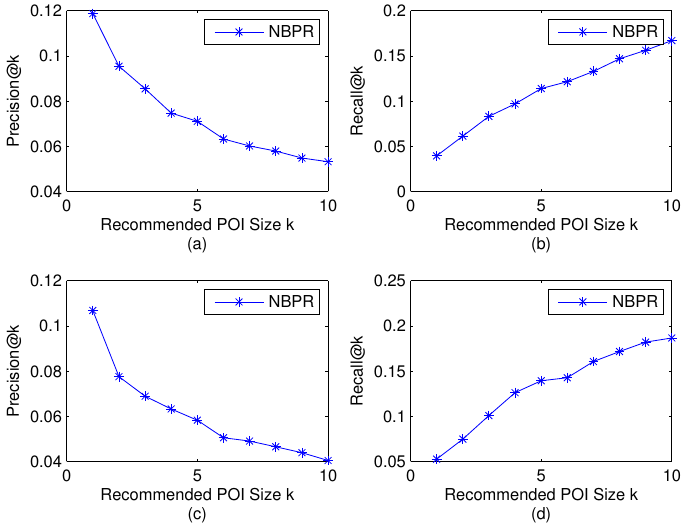
Figure 5. The recommendation performance of our method with the changes of the recommendation number in two LBSNs. ( a ) Precision@ k in the Gowalla data; ( b ) Recall@ k in the Gowalla data; ( c ) Precision@ k in the Brightkite data; ( d ) Recall@ k in the Brightkite